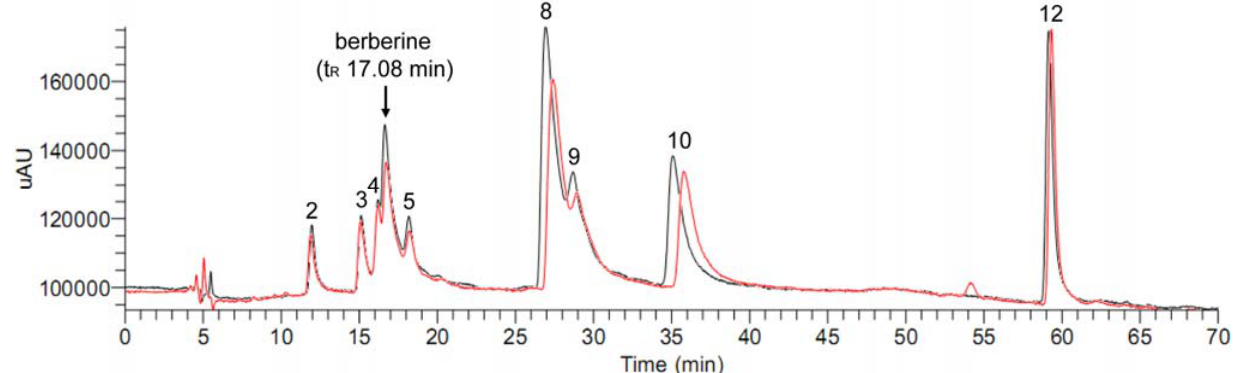
Figure 5. HPLC chromatograms before (black) and after (red) incubation of the mixed reference compounds with aromatase.